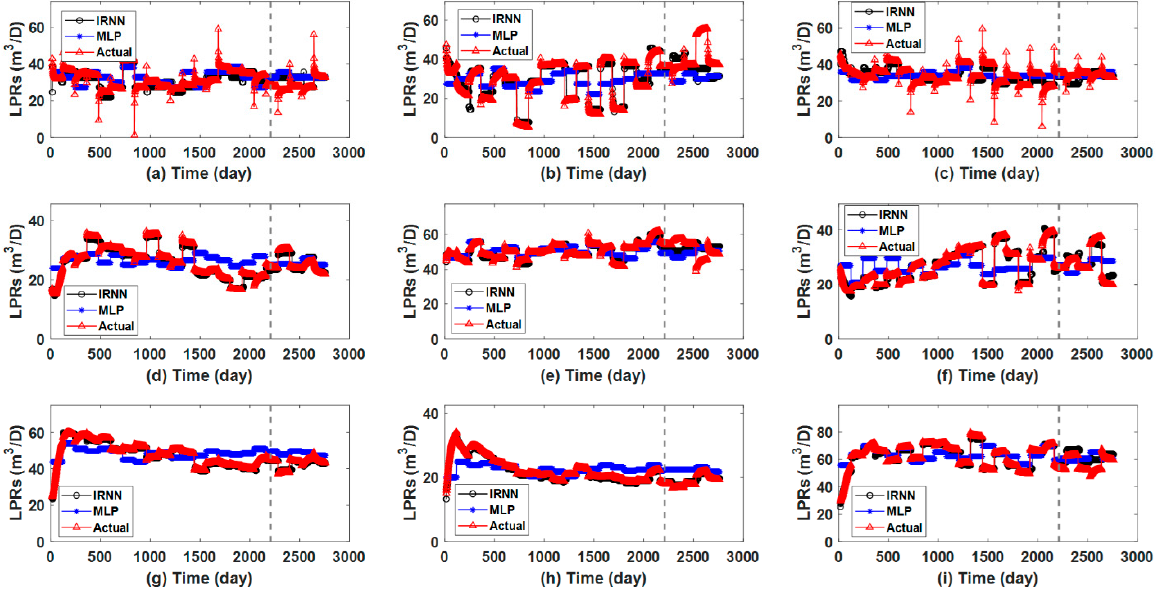
Figure 3. The liquid production rate curves of the three-channel model. The red lines with triangles represent the actual results obtained by the simulator, the black lines with circles represent the results obtained via IRNN, and the blue lines with dots are the results obtained via MLP. The history matching and predicting periods are divided by the grey vertical dashed line. From PRO-01 to PRO-09, the liquid production rates of 9 producers are demonstrated in ( a – i ) successively.